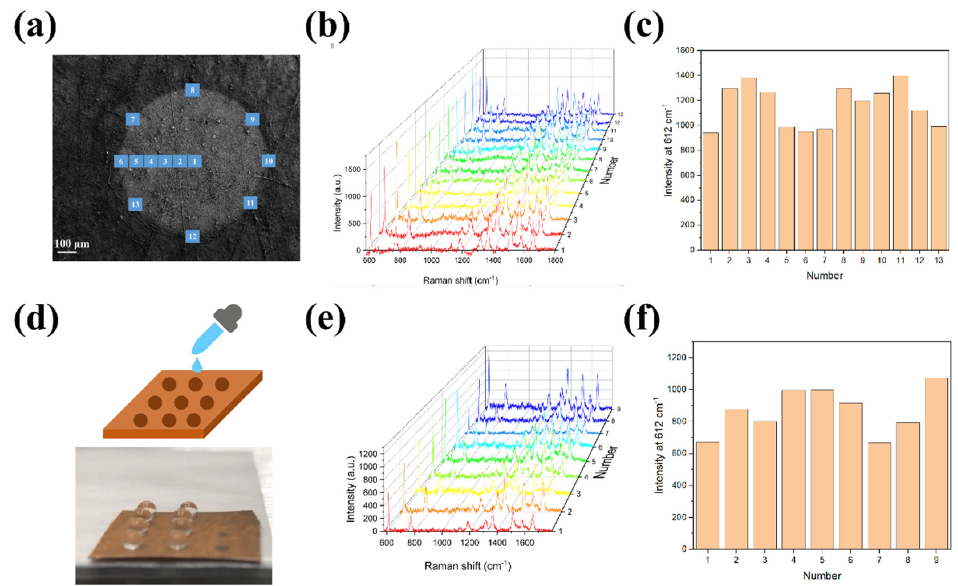
Figure 5. ( a ) SEM image of SERS active area with 13 marked spots. ( b ) The corresponding SERS spectra of R6G from 13 spots ( c ) and the histogram for the peak intensity at 612 cm − 1 . ( d ) Photograph of a SERS chip containing 9 SERS active areas by dropping 20 μ L of R6G. ( e ) The corresponding SERS spectra of R6G from 9 different SERS active areas ( f ) and the histogram for the peak intensity at 612 cm − 1 .